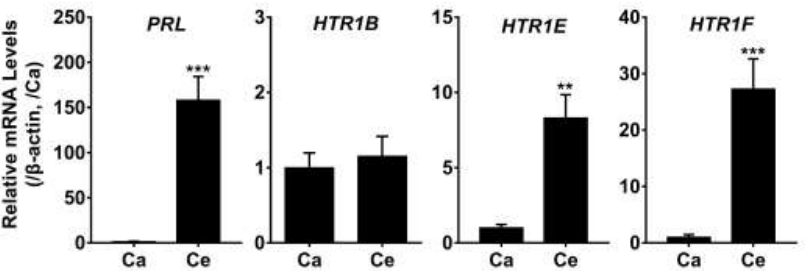
Figure 7. qRT-PCR assay of PRL , HTR1B, HTR1E, and HTR1F mRNA expression in the cephalic lobe (Ce) and caudal lobe (Ca) of adult chicken anterior pituitary, β -actin was used as an internal control. The mRNA levels of target genes were normalized by that of β -actin and expressed as the fold difference compared with that of the caudal lobe (Ca), **, p ≤ 0.01 vs. Ca; ***, p ≤ 0.001 vs. Ca. Each data point represents the mean ± SEM of six replicates ( n =